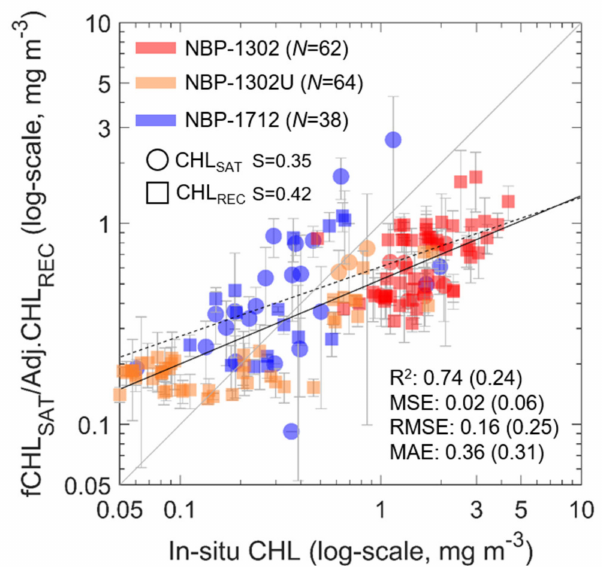
Figure 10. Scatter plot of in situ measured CHL versus CHL SAT and CHL ADJ, which were derived from the RF model. The circles represent the in situ CHL which match the averaged CHL SAT value on 5 × 5 pixels and the squares represent the regions where the CHL ADJ do not match CHL SAT . Error bars denote the standard deviations of the mean on the 5 × 5 pixels. Light red, orange and blue colors denote NBP1302, NBP1302U and NBP1712, respectively. Solid and dashed lines represent the linear regression lines for CHL SAT and CHL REC , respectively. Black lines refer to the total in situ